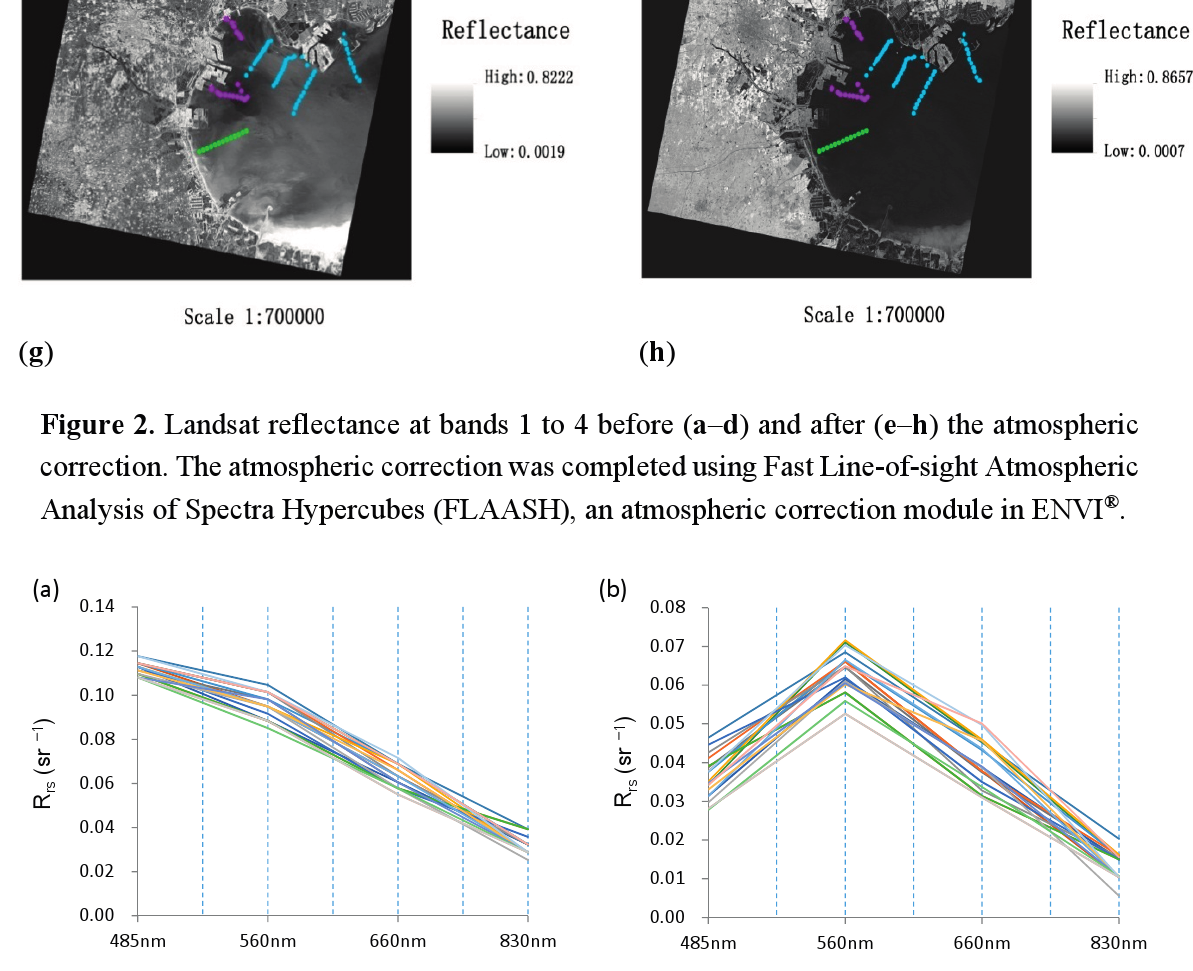
Figure 3. The graphs of the remote sensing reflectance spectra for the stations before ( a ) and after ( b ) atmospheric correction from band 1 to band